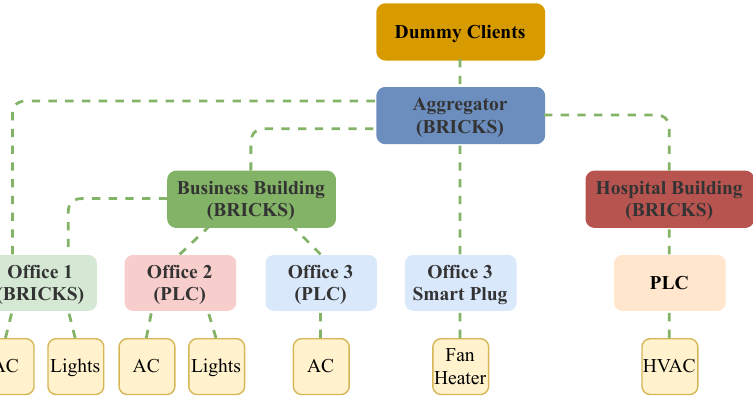
Figure 4. The case study scenario.